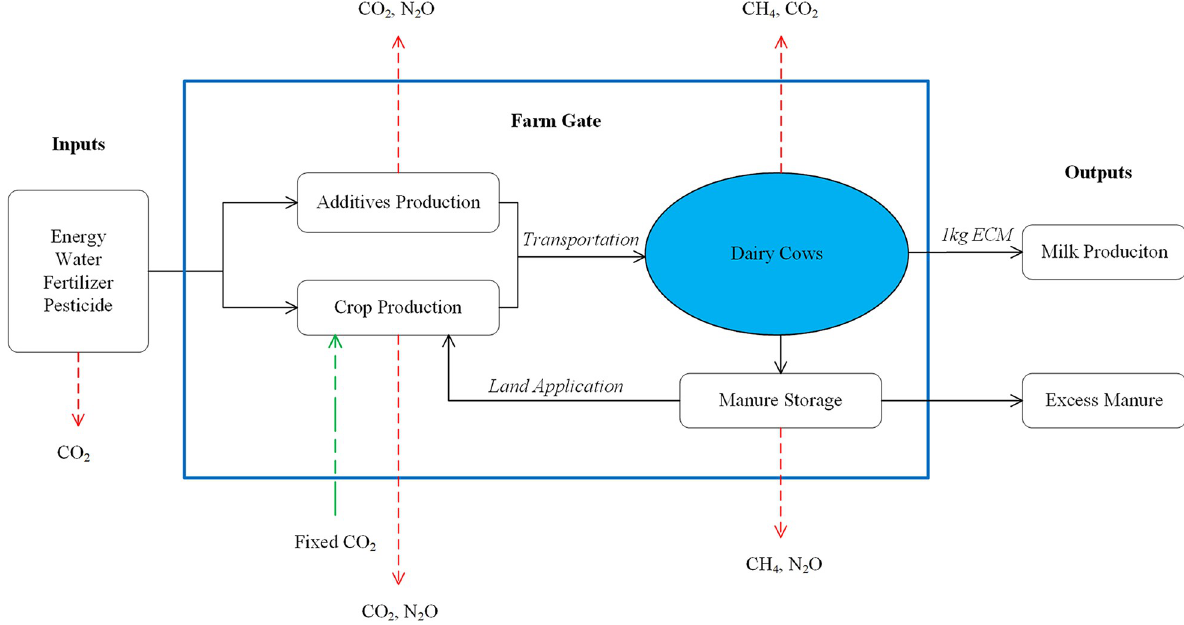
Fig 1. System boundary of the life cycle assessment for California milk